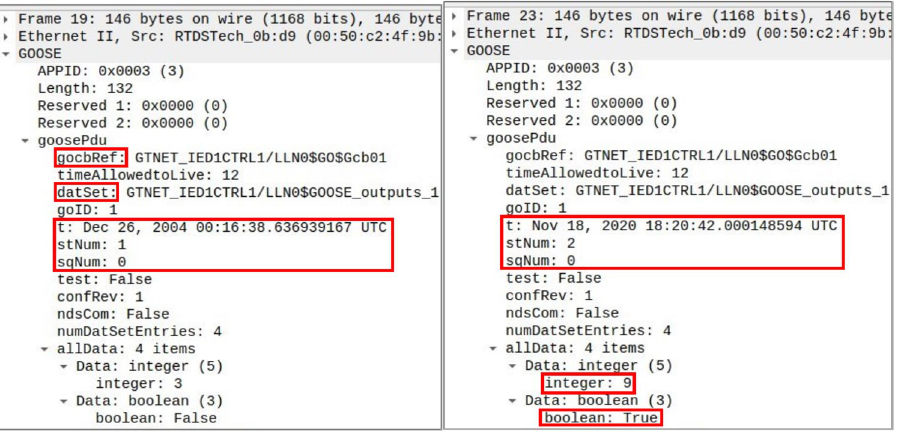
Figure 5. Original and counterfeit GOOSE packets for IED 1 on LAN port 6 .